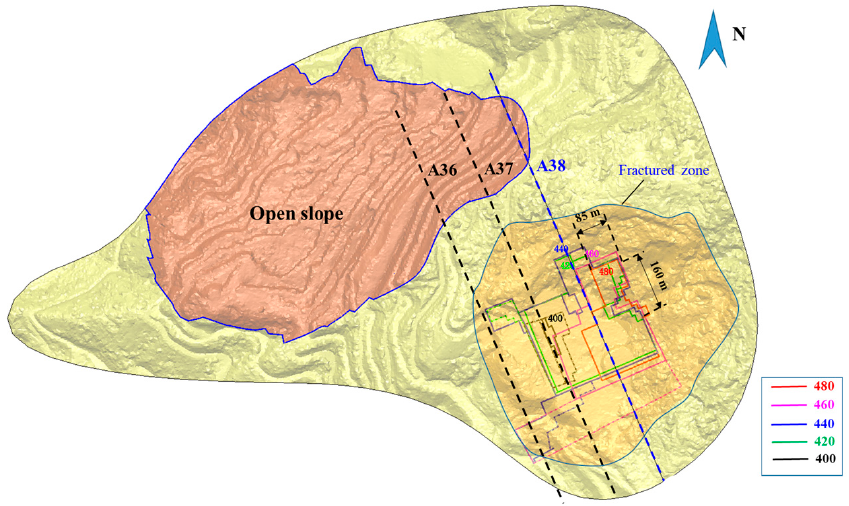
Figure 4. Plan of the open-pit and underground caving combined mining in Dahongshan Iron Mine.